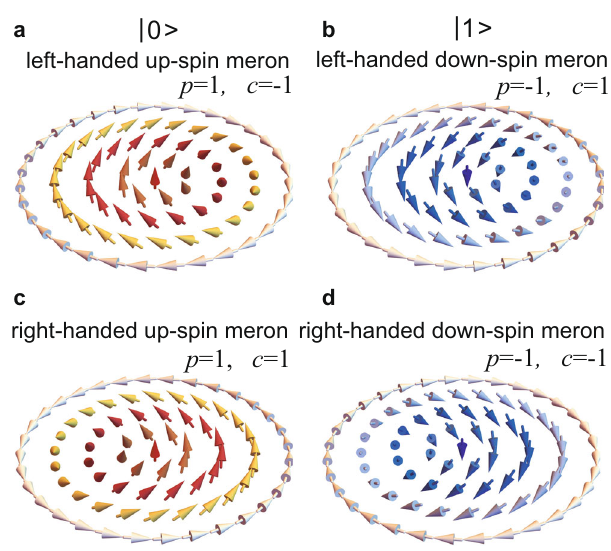
Fig. 1 Schematic illustration of Bloch-type merons. a A Bloch-type meron with polarity p = 1 and chirality c = 1 representing the qubit state 0 j i . b A Bloch-type meron with p = − 1 and c = − 1 representing 1 j i . c A Bloch-type meron with p = 1 and c = − 1. d A Bloch-type meron with p = − 1 and c = 1. a and b are the left-handed merons, while c and d are right-handed merons. The right-handed merons have higher energy than the left-handed merons due to the DMI considered in this work. The arrow represents the spin direction. The out-of-plane spin components are color-coded by the red and blue color scheme: the red arrow points in the + z direction and the blue arrow points in the − z